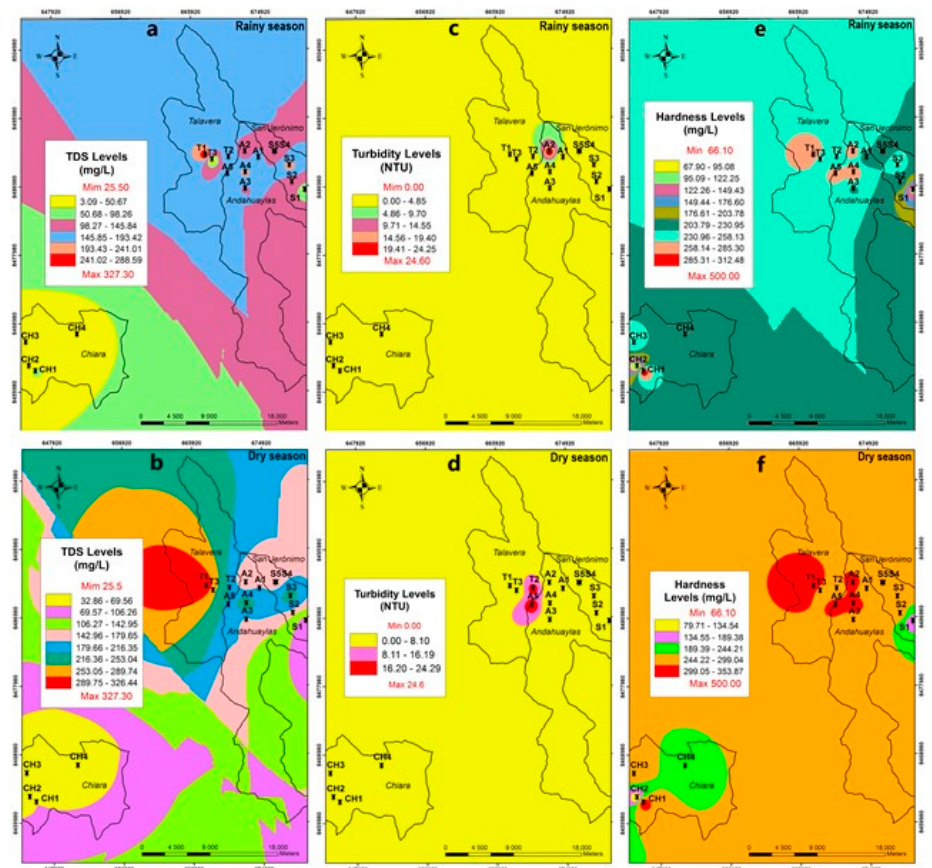
Figure 5. ( a ) TDS in rainy season, ( b ) TDS in dry season, ( c ) turbidity in rainy season, ( d ) turbidity in dry season ( e ), hardness in rainy season, and ( f ) hardness in dry season, in the sampling areas. In the same way, the level of dissolved oxygen (DO) was found in the range from